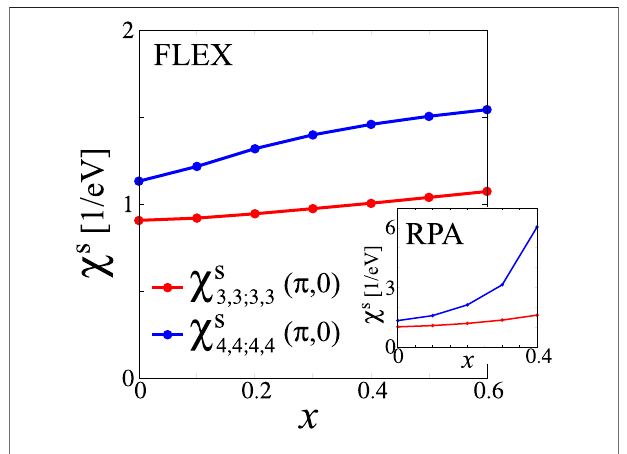
( π , 0 ) in the FLEX , 3 ; 3 , 3 ( 4 , 4 ; 4 , 4 )